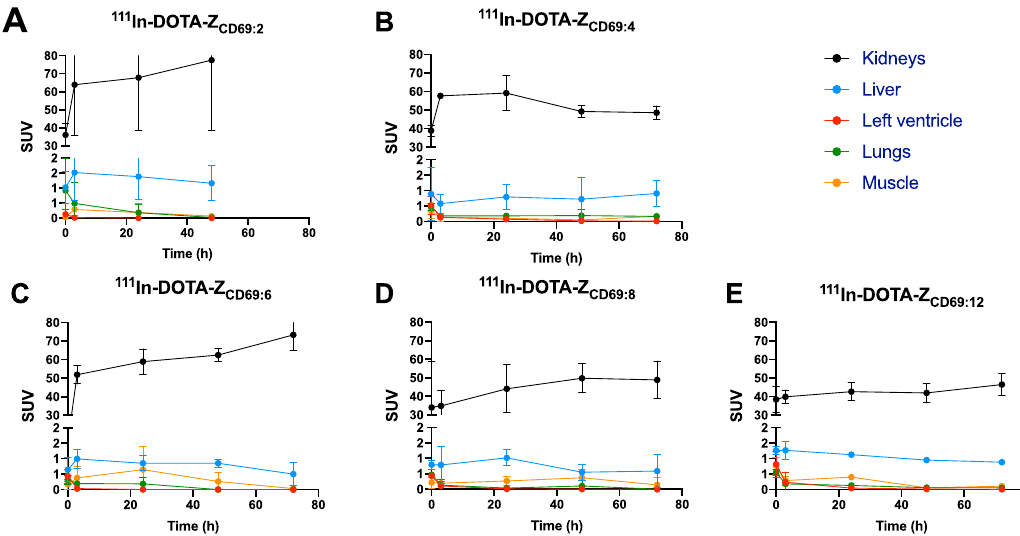
Figure 6. Dynamic uptake over time in kidney, liver, heart left ventricle (i.e. blood compartment), lungs and muscle tissue (average and standard deviations of n = 3 rats each) as assessed by SPECT/CT for 111 In-DOTA- Z CD69:2 ( A ), 111 In-DOTA-Z CD69:4 ( B ), 111 In-DOTA-Z CD69:6 ( C ), 111 In-DOTA-Z CD69:8 ( D ) and 111 In-DOTA-Z CD69:12 ( E